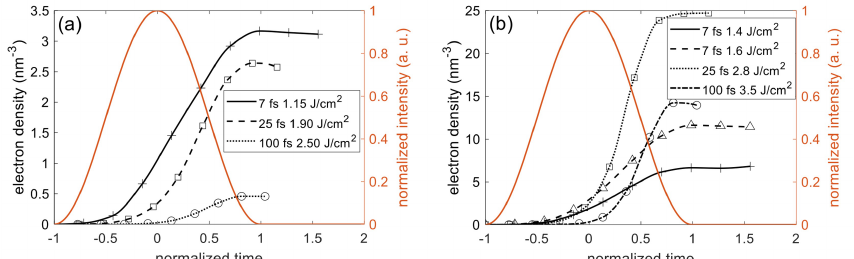
Figure 5. Electron density evolution for different pulse durations at LID thresholds ( a ) and ablation thresholds ( b ) based on measurements in [27,47]. The orange curve represents the intensity profile of the laser pulse and the time is normalized by the pulse duration. The crosses, squares, and circles represent the simulation data points for the 7 fs, 25 fs, and 100 fs pulses, respectively. The triangles also represent the simulation data points for the 7 fs pulse. The lines through the simulation points are merely to guide the